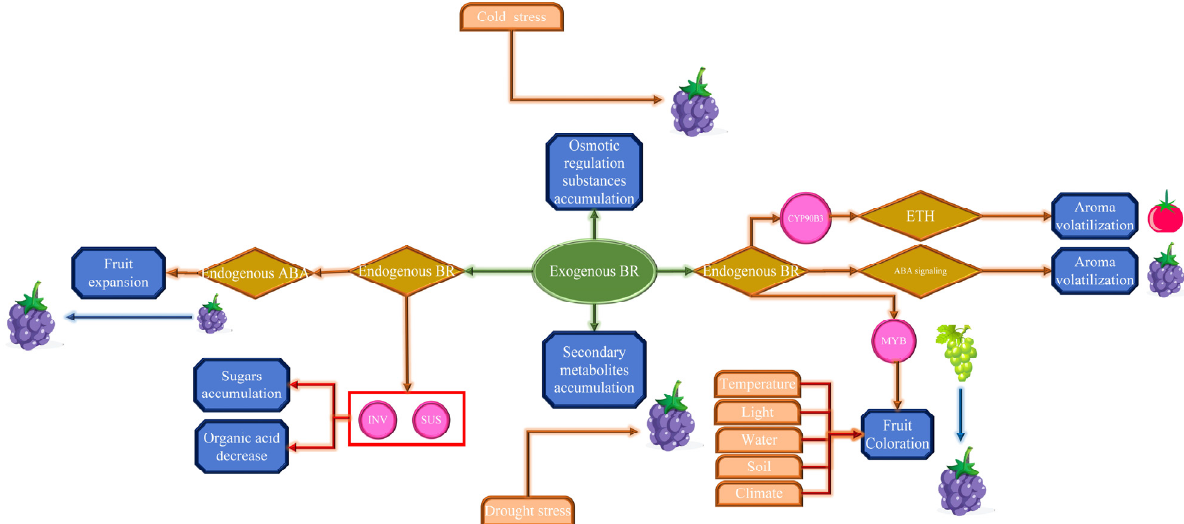
Figure 5. The effect of BR on the berry development and fruit quality improvement. Dark-blue frame displayed the main physiological activity related to fruit quality improvement, including fruit ex- pansion, sugars accumulation, organic acid decrease, fruit coloration and aroma volatilization. The tan frame and green frame display various endogenous phytohormones, such as ABA, BR, and ETH. Incarnadine frame displayed different environmental factors, namely temperature, light, water, soil, climate, and stress. The pink frame displays structural genes and transcription factors involved in these processes, comprising INV , SUS , MYB, and CYP90B3. ( → ) indicated the regulating effect, while ( ⟞ ) indicated inhibiting